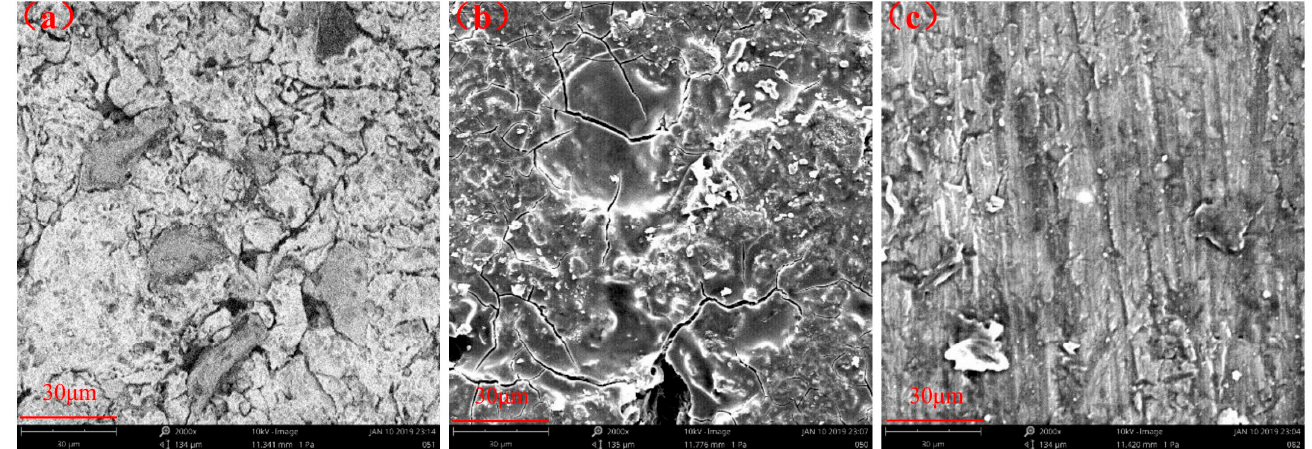
Figure 9. SEM morphology of the coatings after 48 h of salt-spray corrosion: ( a ) A5001; ( b ) A0050; ( c ) A0082. ( c )